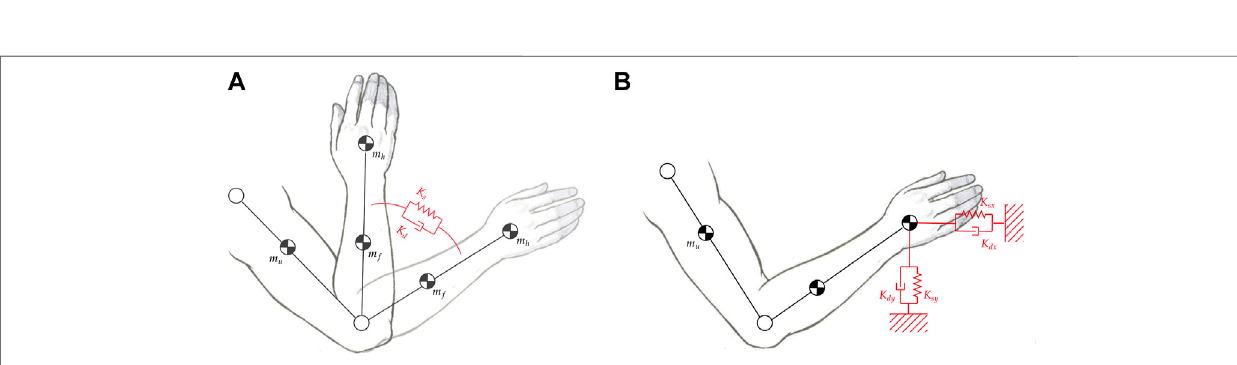
FIGURE 4 | (A) First order impedance model applied at the elbow joint in the joint-space. (B) First order impedance model applied at the elbow joint in the Cartesian-space.